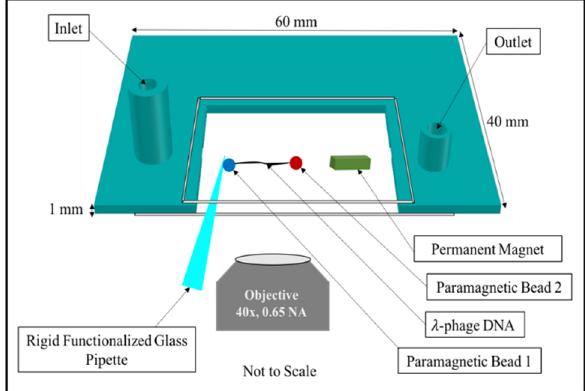
Figure 7. This figure shows a schematic diagram for the horizontal magnetic tweezers. Each end of the λ -DNA was attached to a superparamagnetic bead coated with streptavidin. One bead was also attached to the surface of the functionalized glass pipette and the other bead was suspended near a 3 mm × 2 mm × 1 mm neodymium bar magnet attached to the floor of the sample cell. The inlet and outlet of the sample cell were used to introduce core histones and NAP 1 proteins and for buffer exchange. The sample cell was composed of a 3D custom printed spacer and two coverslips, one with the dimensions of 22 mm × 40 mm (glued at the bottom of the spacer forming the floor of the sample cell) and another with the dimensions of 22 mm × 22 mm (glued to the top of the spacer, forming the ceiling of the sample cell).